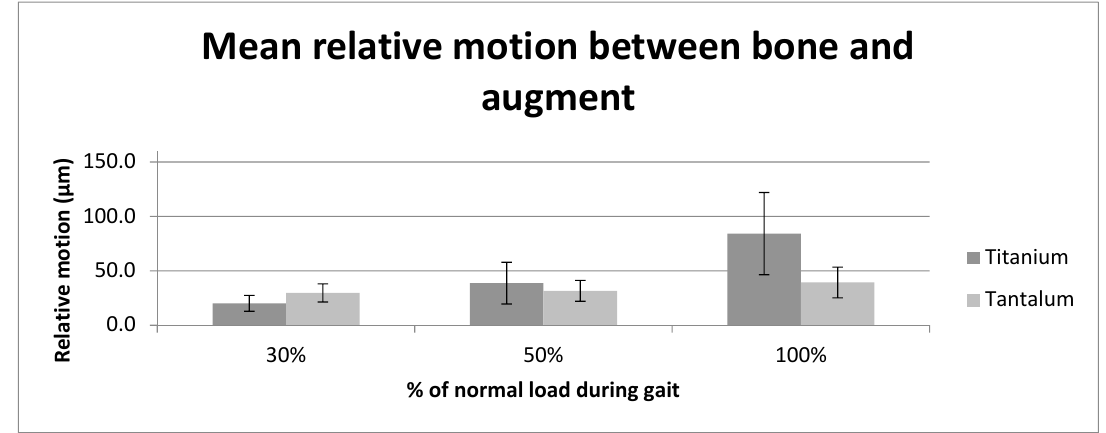
Figure 4. Graph shows the average relative motion ( µ m) between the tantalum and titanium augment and adjacent composite bone at the three tested load levels (30%, 50% and 100% load).